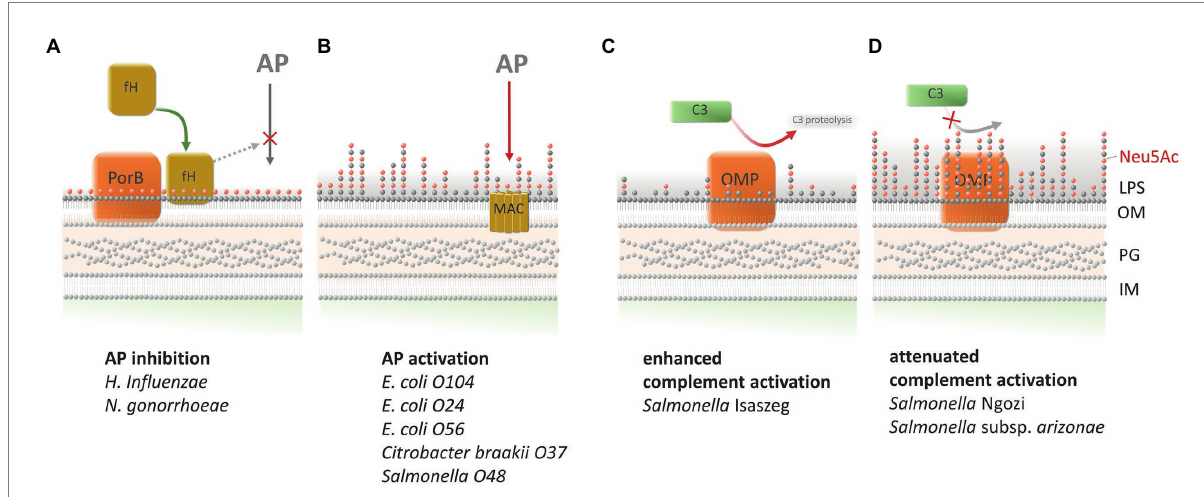
FIGURE 3 Correlation between the presence of NeuAc in bacterial LPSs and complement activation. There are four possible ways of C activation depending on sialylated LPSs and outer membrane proteins. (A) The sialylated LOS of Haemophilus influenzae and Neisseria gonorrhoeae inhibits the activation of the alternative pathway (AP) of the complement system by binding of factor H. The binding of factor H requires the presence of gonococcal outer membrane protein PorB (Ram et al., 1998; Figueira et al., 2007; Madico et al., 2007). (B) Enterobacteriaceae such as Escherichia coli O104, E. coli O24, E. coli O56, Citrobacter braakii O37 and Salmonella O48 were killed via the AP pathway activation although they possessed sialylated LPSs (Bugla-Płoskońska and Doroszkiewicz, 2006; Bugla-Płoskońska et al., 2010a,b). (C) LPS with a low content (near the limit of detection) of sialic acid in LPS of Salmonella Isaszeg enabled C3 activation on OMPs in the range of molecular masses of 35–48 kDa (Futoma- Kołoch et al., 2015). (D) LPS with a high content of sialic acid of S. Ngozi and S. subsp. arizonae impeded C3 activation by OMPs in the range of molecular masses of 35–48 kDa (Futoma-Kołoch et al.,